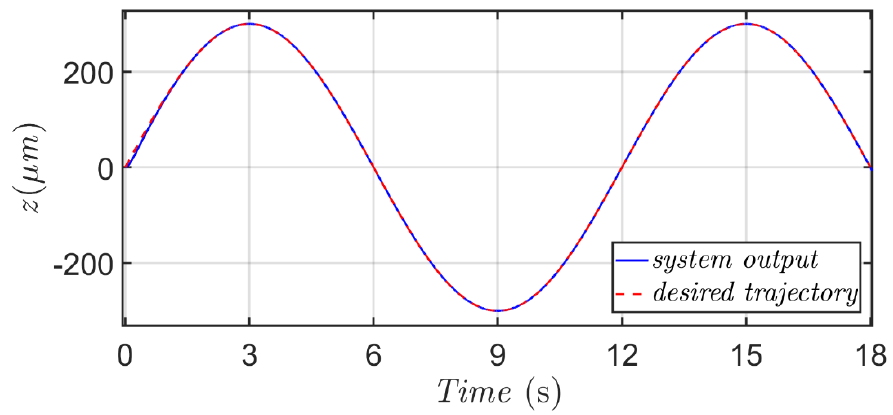
Figure 19. History of the proposed micro-positioning actuator for a desired sinusoidal-type trajectory.